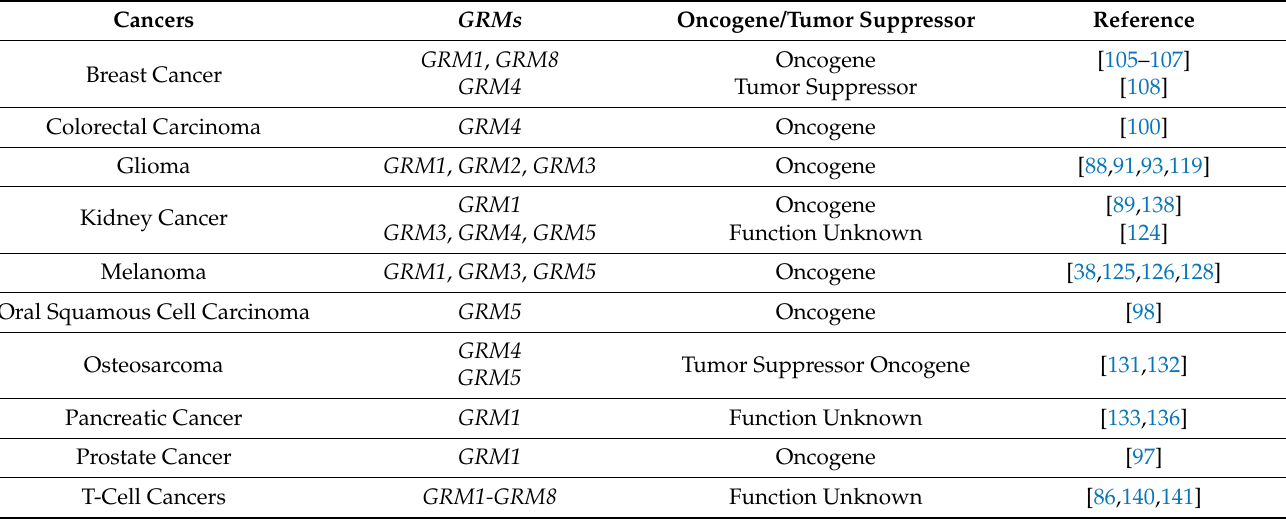
Table 1. GRMs function as an oncogene or tumor suppressor in various